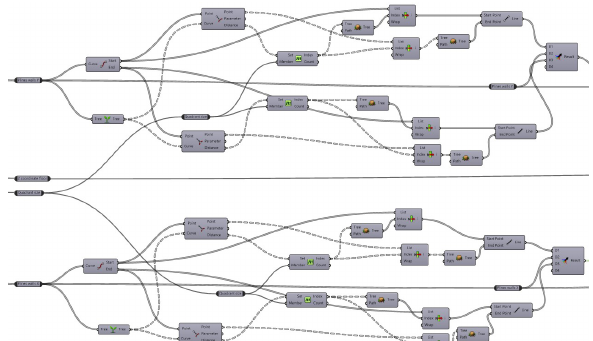
Figure 1 . Visual programming with grasshopper, part of the graph developed for this